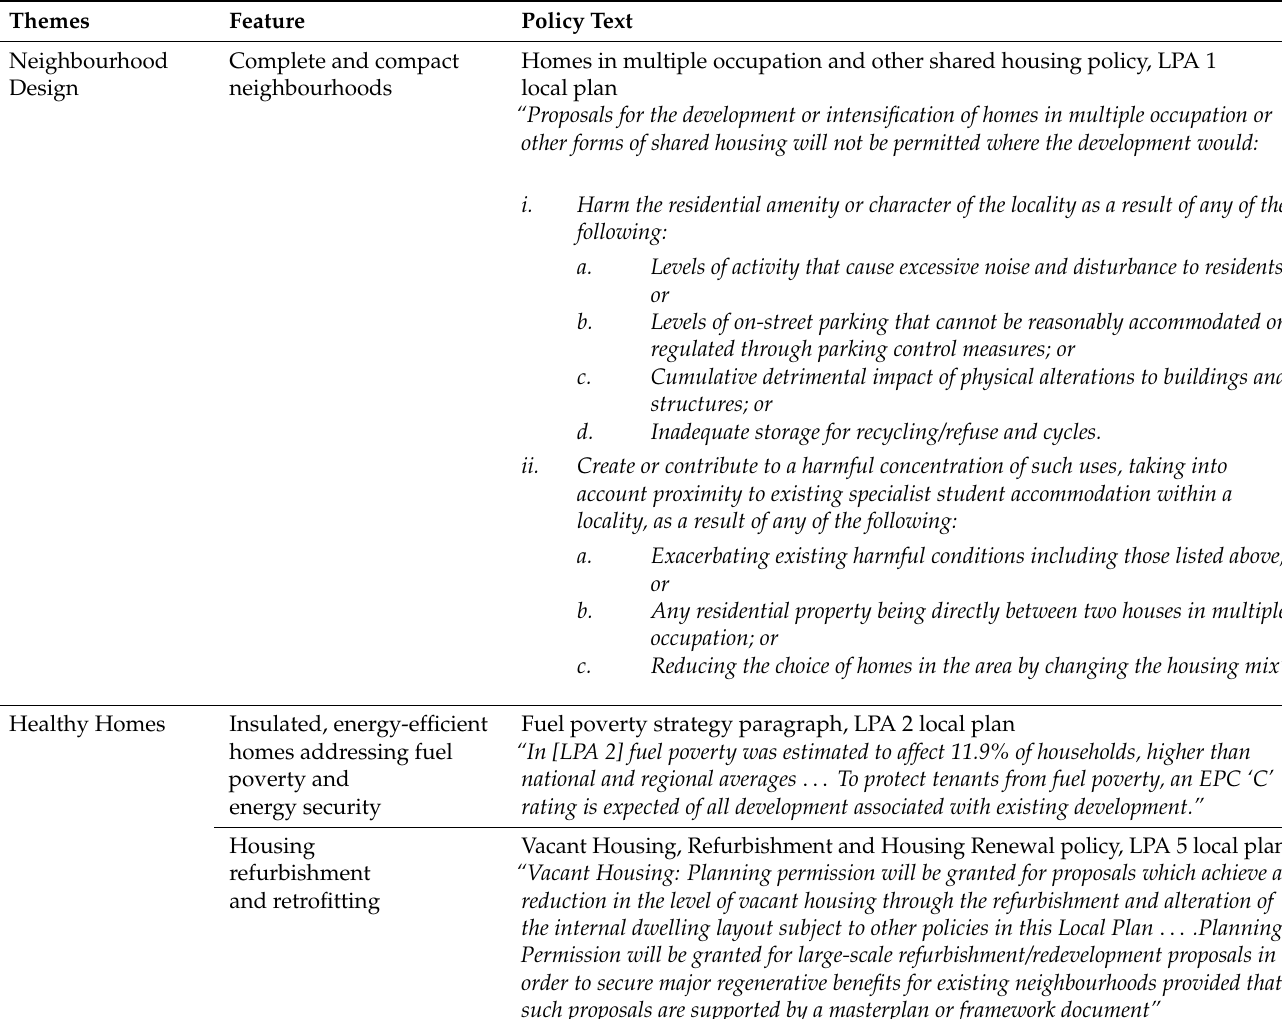
Table A3. Local plan policy examples of health requirements for